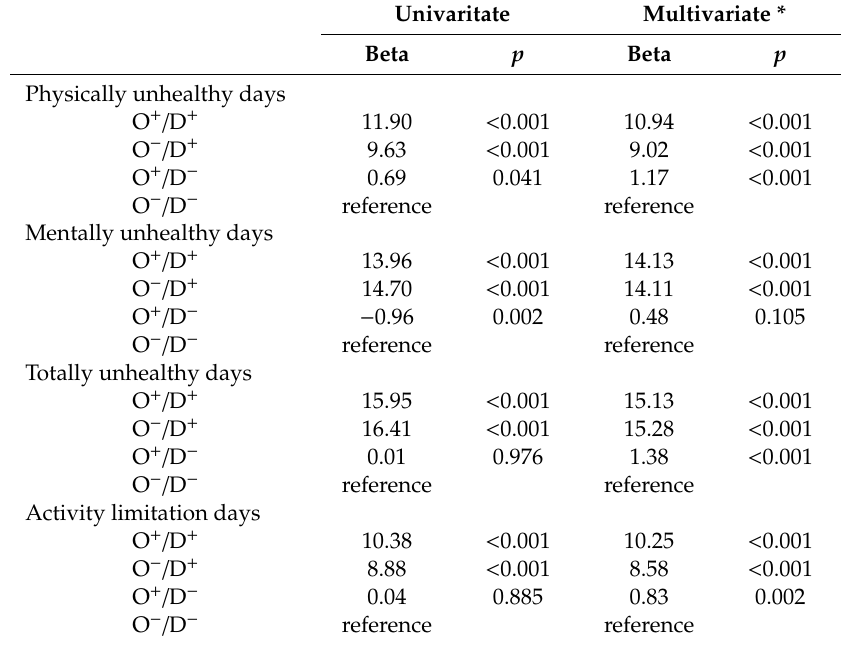
Table 3. Linear regression analysis of HRQoL.